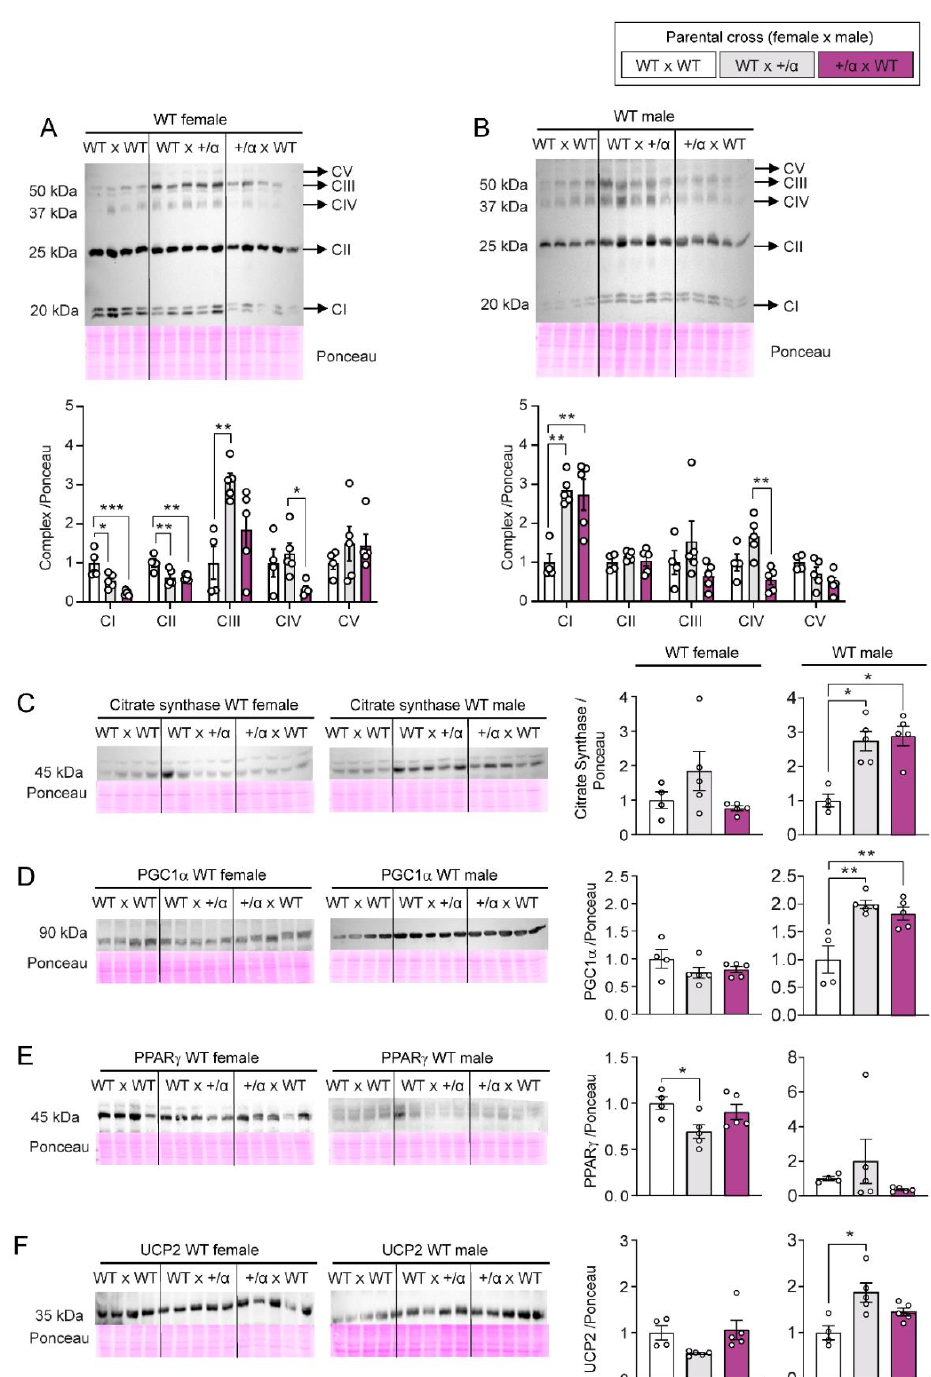
Figure 4. Protein abundance of mitochondrial complexes and key mitochondrial regulatory proteins in placental labyrinth of WT conceptuses in response to littermate and/or maternal p110 α deficiency. Relative protein abundance of mitochondrial complexes in females ( A ) and males ( B ), as well as citrate synthase ( C ), PGC1 α ( D ), PPAR γ ( E ), and UCP2 ( F ) in females and males. Representative images from each antibody and Ponceau staining are included. Data are from 1 WT fetus per dam generated by WT x WT ( n = 4), WT x α /+ ( n = 5), and α /+ x WT ( n = 5) parental crosses and are displayed as individual data points with mean ± S.E.M. Data were analysed by one-way ANOVA and Tukey post hoc pairwise comparisons (* p < 0.05, ** p < 0.01, *** p < 0.001, pairwise comparison).